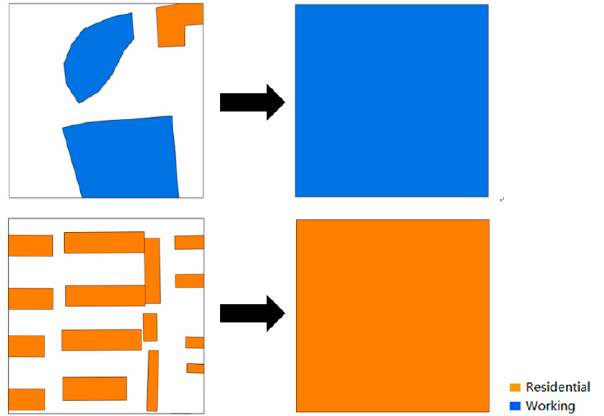
Figure 3. Examples of standard grid function definitions.